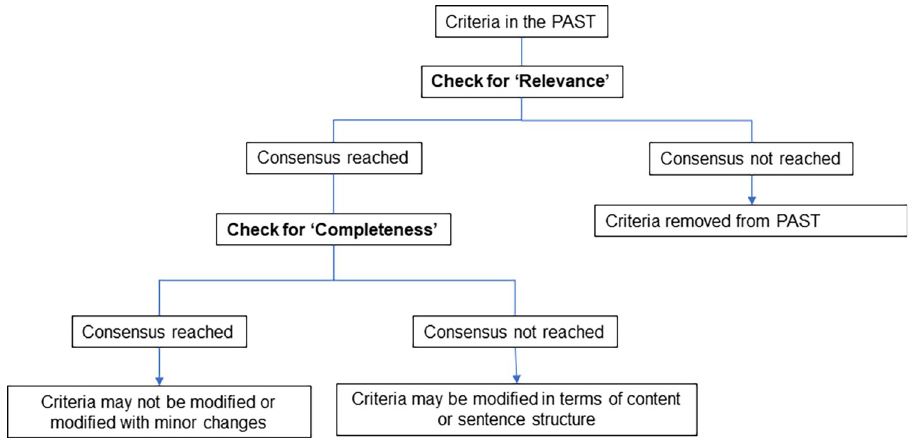
Fig 1. Consensus of agreement and actions to be